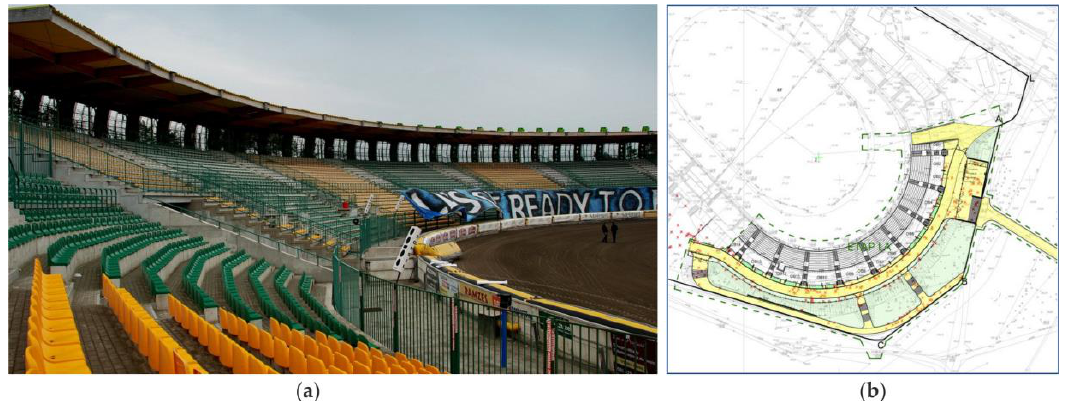
Figure 2. Swiss Krono Arena: ( a ) the view on the grandstand, ( b ) the location of the grandstand on the land development plan.